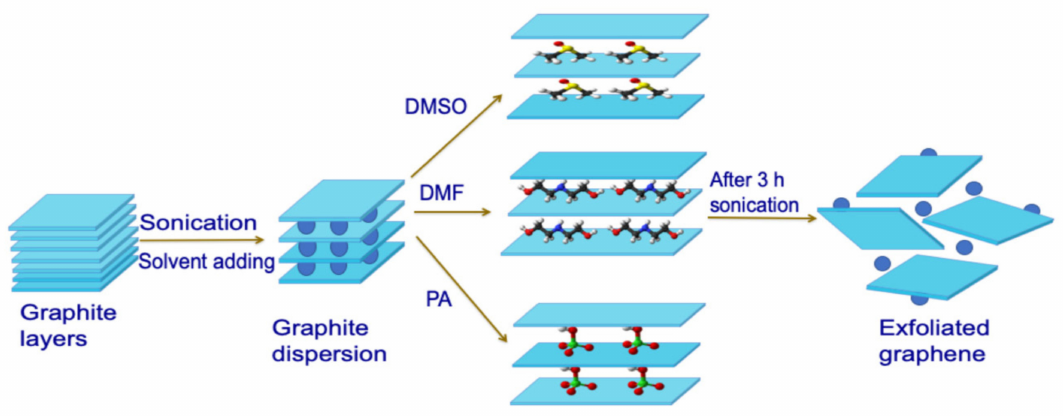
Figure 5. Schematic representation of the liquid phase exfoliation method [Reprinted with permission from ref. [48] Gürünlü, B.; Ta¸sdelen-Yüceda˘g, Ç.; Bayramo˘glu, M. Graphene Synthesis by Ultrasound Energy-Assisted Exfoliation of Graphite in Various Solvents. Crystals 2020 , 10 , 1037. https://doi.org/ 10.3390/cryst10111037, Copyright © MDPI].